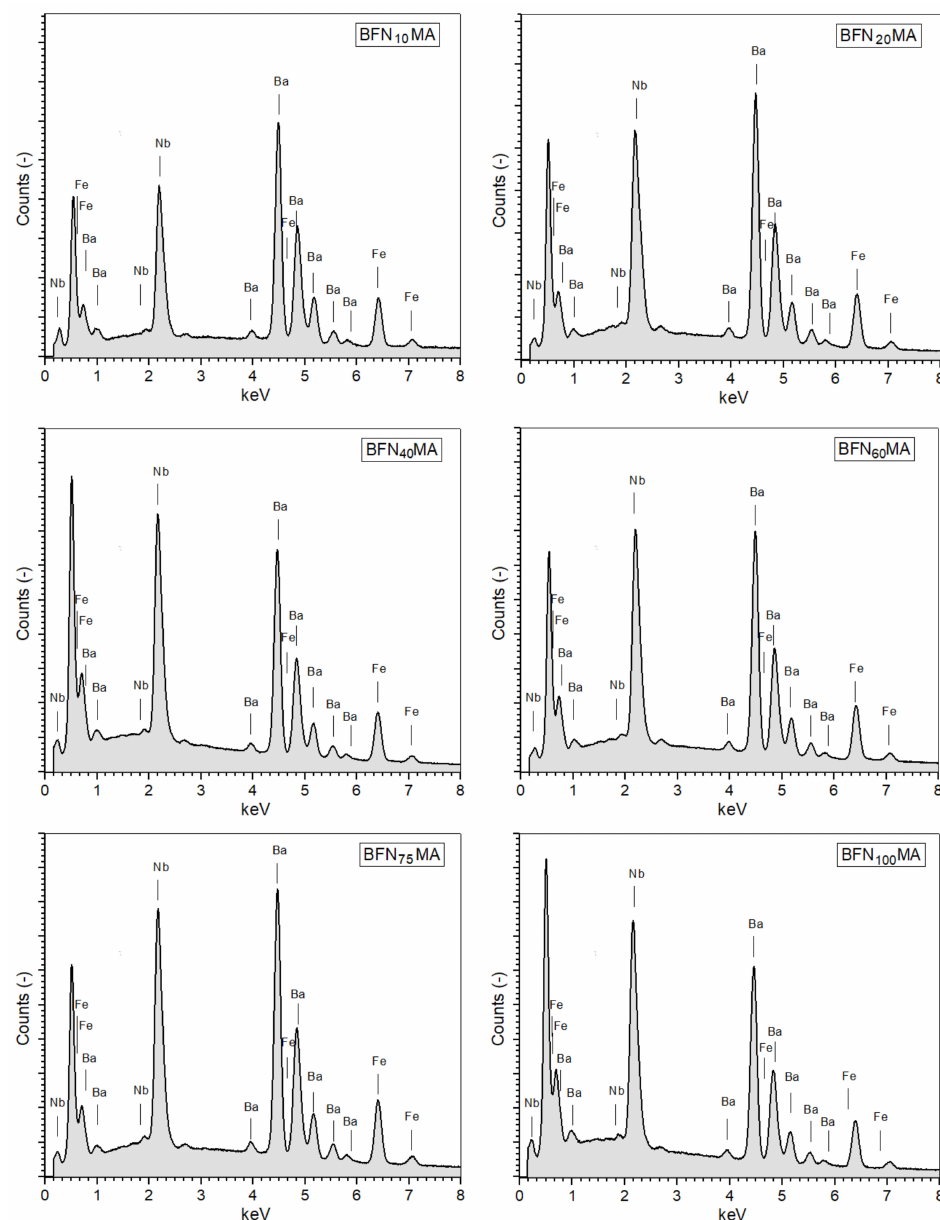
Figure 3. The Energy Dispersive Spectrometry (EDS) analysis of chemical elements of the BFN x MA